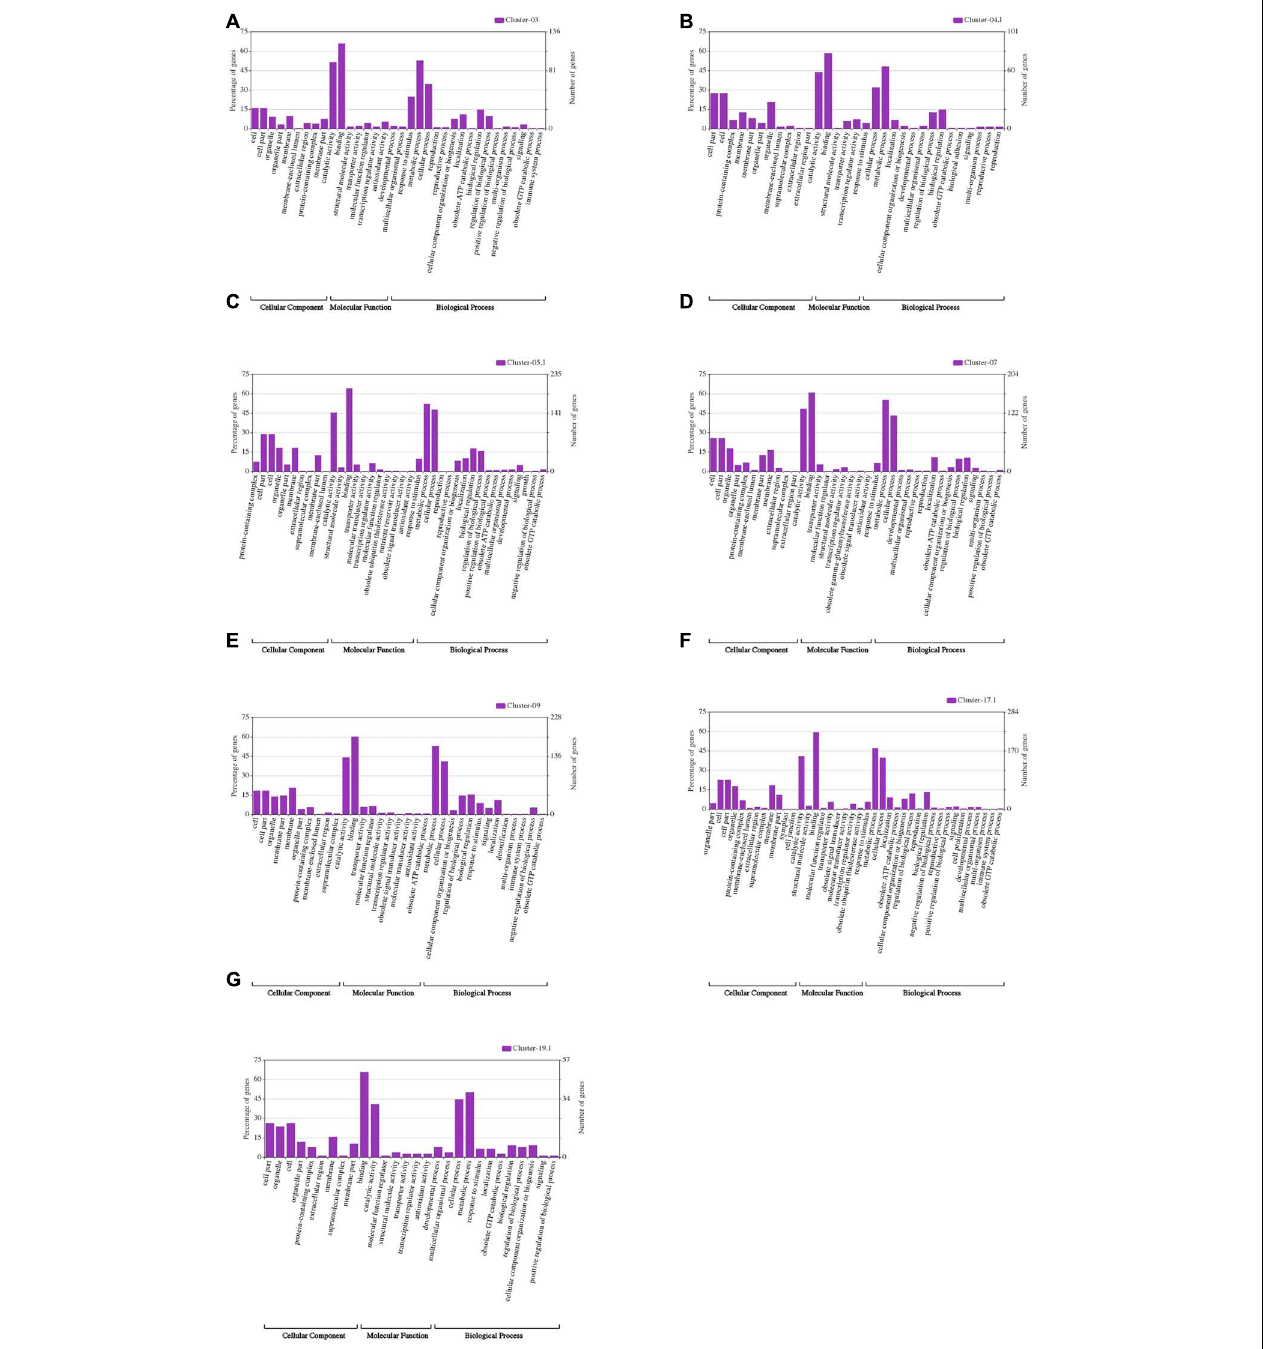
FIGURE 6 | WeGO analysis of the genes located within the seven major QTL clusters: (A) Cluster-03; (B) Cluster-4.1; (C) Cluster-5.1; (D) Cluster-07; (E) Cluster-09; (F) Cluster-17.1; and (G) Cluster-19.1.